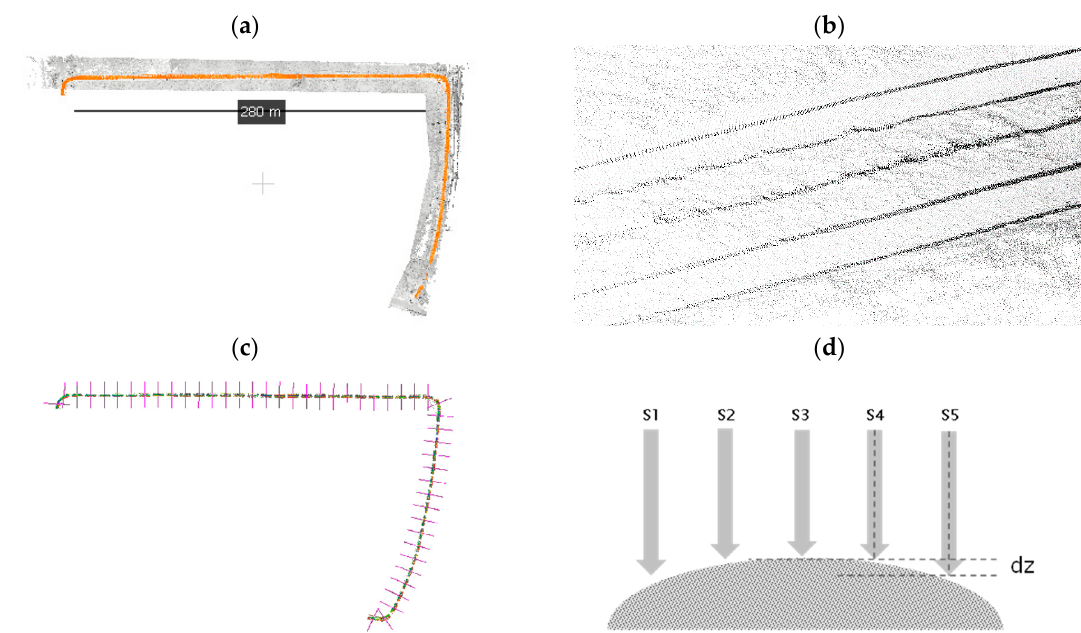
Figure 2. Data processing and evaluation steps: ( a ) combination of terrestrial laser scanning (TLS, grey background area) and road scanner measurements (orange); ( b ) reference sensor lane extraction (black) from the TLS data background (grey); ( c ) longitudinal segmentation of both data sources with 2 m spacing; and ( d ) calculating the mean height difference (dz) to represent the lateral water-flow between two sensor lanes, visualized between sensor 4 (S4) and sensor 5 (S5) of one segment.